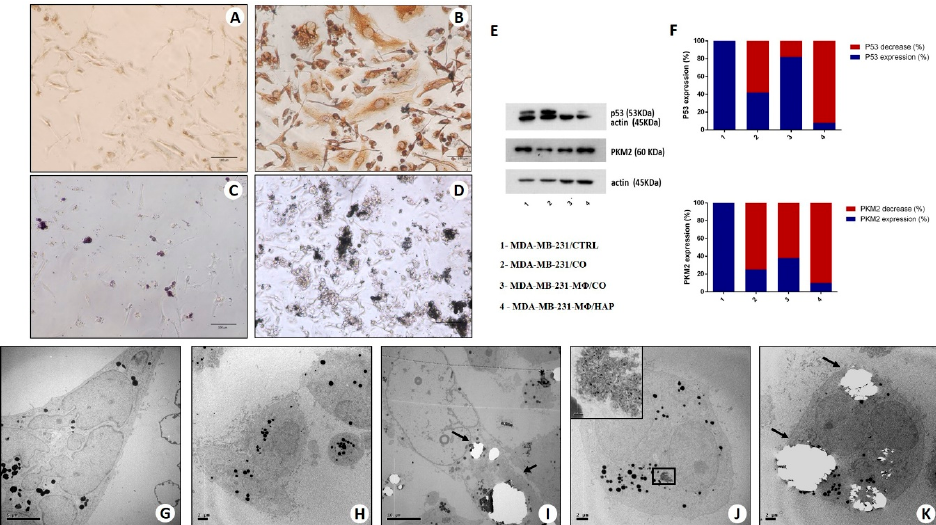
Figure 6. In Vitro model of BOLCs development. ( A ) Immunocytochemical analysis of MDA-MB-231 alone (MDA-MB-231/CTRL) shows no/rare vimentin-positive cells. ( B ) Several vimentin-positive MDA-MB-231 cells are present after co-culture with CO and activated monocytes. ( C ) Image displays starting point of MDA-MB-231 cells incubated with CO and activated monocytes. ( D ) After 10 days of culture, several large calcified nodules are present. ( A – D ) scale bars represent 100 µ m ( E ) Western blot analysis for Tumor protein 53 (p53) and Pyruvate kinase Muscle (PKM) 2. ( F ) Western blot densitometric analysis (%) of p53 and PKM2 expression compared with the respective controls (MDA). ( G , H ) The ultrastructural aspect of MDA-MB-231 (CTRL). ( I – K ) Breast Osteoblast-like cells with hydroxyapatite intra-cytoplasmatic electron-dense granules (arrows) in MDA-MB-231 + Co + activated